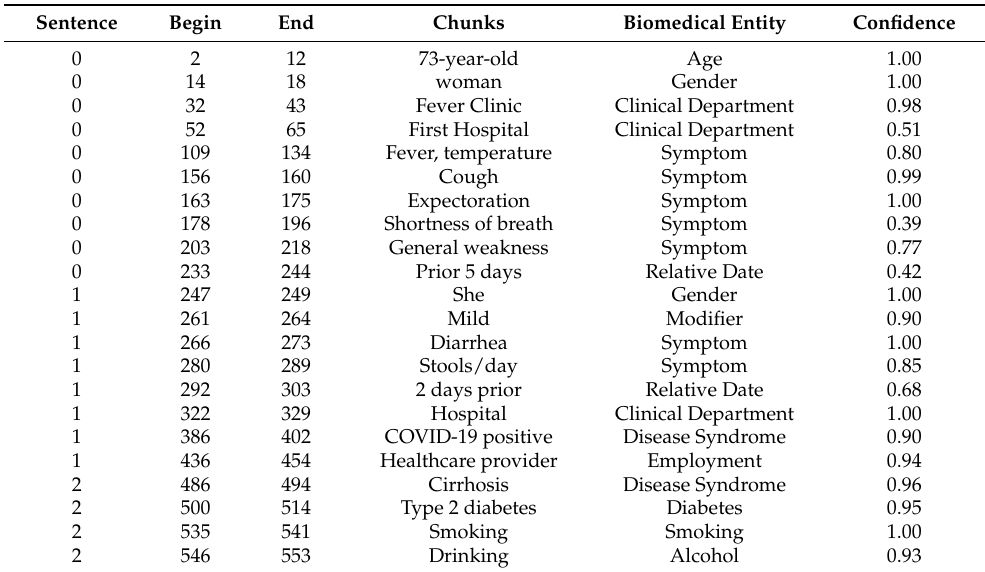
Table 8. Test Results on all Datasets using different Methods.